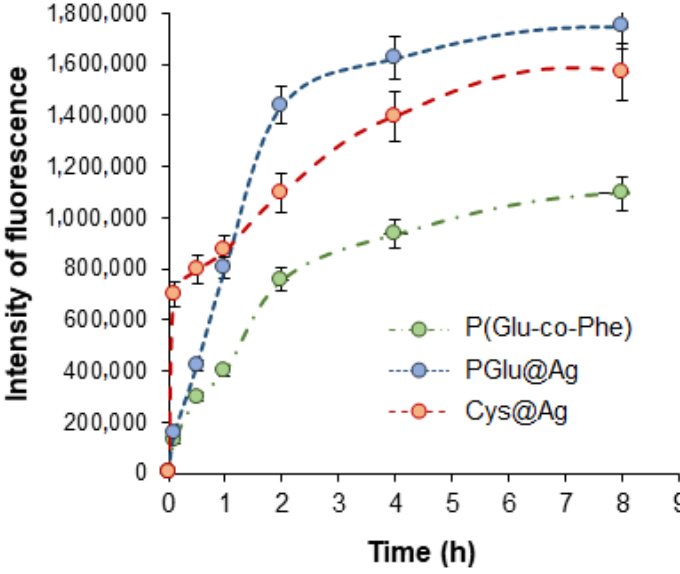
Figure 6. Uptake of different nanoparticles by macrophages (J7741.A). As an additional experiment, the uptake of NPs by macrophages was visualized by fluorescence microscopy (Figure 7) after 3 h of co-incubation. Analysis of the images supported the results of flow cytometry regarding the capture of NPs by macrophages by nonspecific